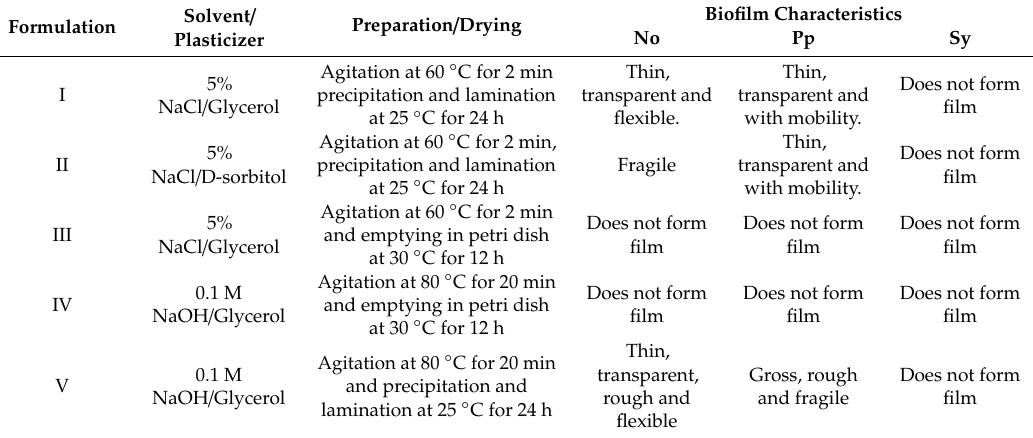
Table 2. Characteristics of the biofilms of precipitates obtained from the crude extracellular medium. Formulation